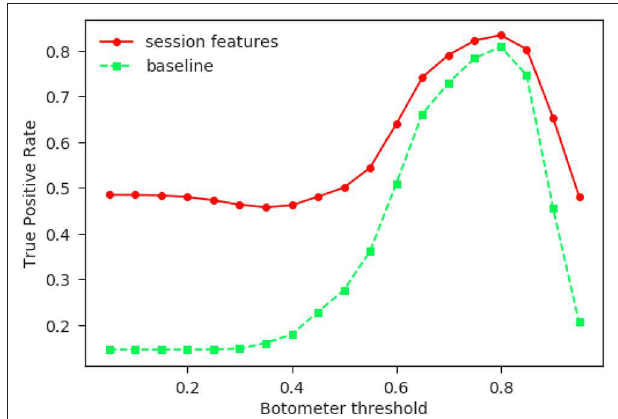
FIGURE 6 | Comparison of the two AB classifiers. In this figure we compare the performance of the AB classifiers trained with (red circles) and without (green squares) including the session features. Both classifiers are trained on the HL and tested on the FE data. The set of “positives” is taken as all the tweets posted by accounts scoring more than the corresponding Botometer score (horizontal axis), and could indeed contain some human accounts, especially for lower values. Nonetheless, the higher TPR goes to show that the introduction of the session features significantly improves the performance of the